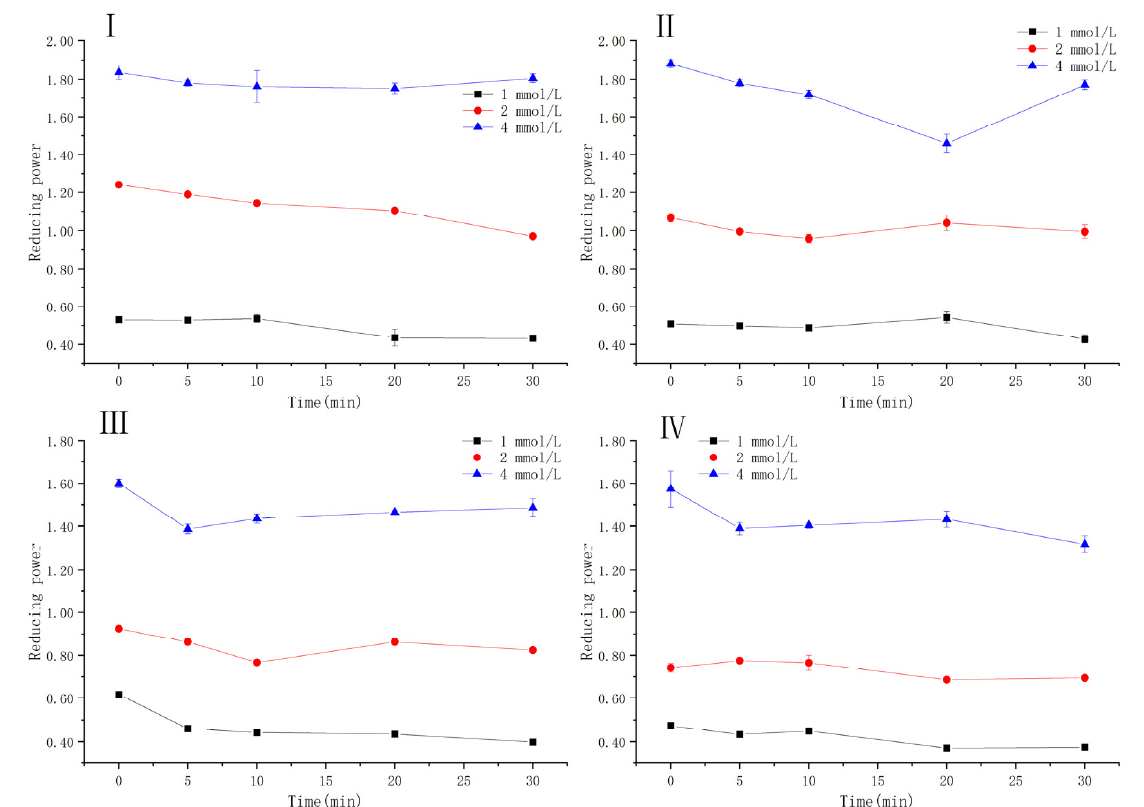
Figure 7. The reducing power of enzymatic browning products of ( I ) Catechin ( II ) Epicatechin ( III ) Caffeic acid ( IV ) Chlorogenic acid in various concentrations at pH 6.8.